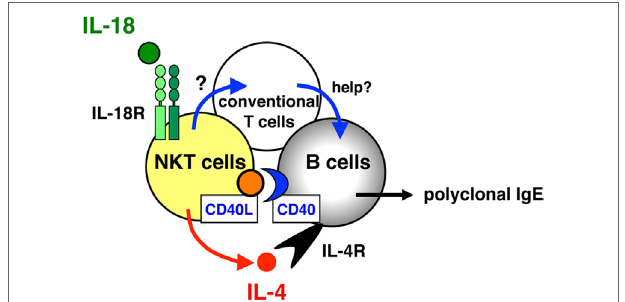
FigURe 2 | Role of natural killer T (NKT) cells and conventional T cells for interleukin (IL)-18-induced IgE production in vivo . NKT cells, strongly positive for the IL-18R α chain, are a critical subset of CD4 + T cells that respond to IL-18 by the expression of IL-4 and CD40 ligand (CD40L) in vivo , and conventional CD4 + T cells act as helper T cells together with NKT cells in IL-18-induced IgE responses.